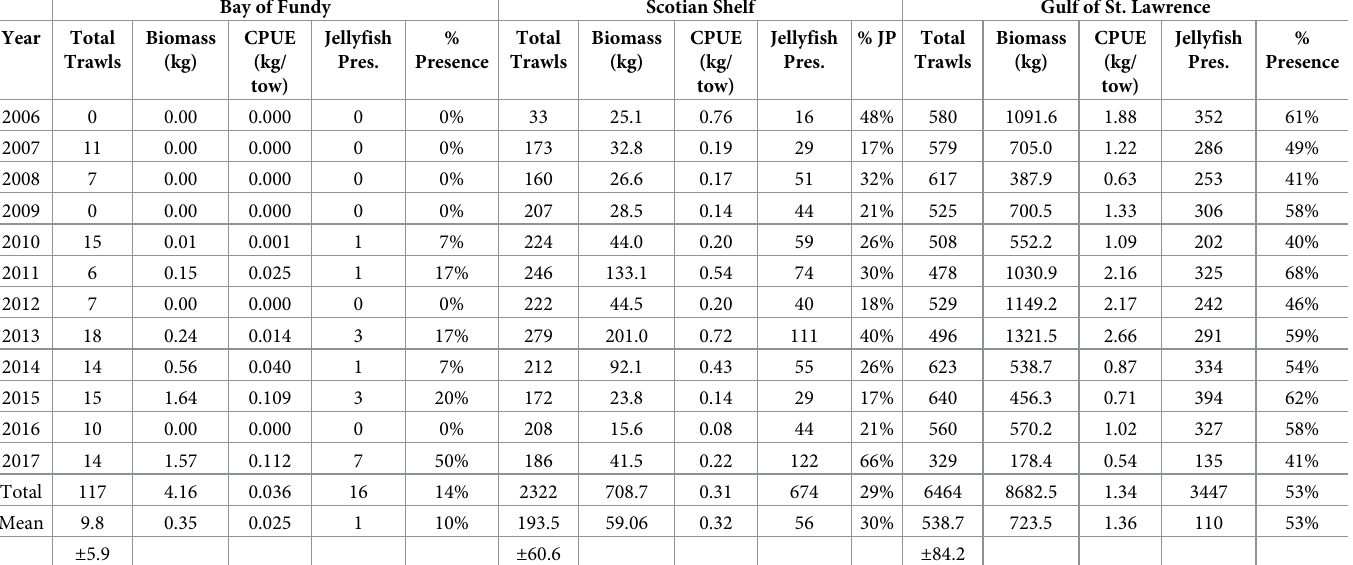
Table 1. DFO groundfish surveys by region and year. ‘Biomass (kg)’ is the wet weight of jellyfish; ‘CPUE’ = catch per unit effort; ‘Jellyfish Pres’ is the number of trawls with jellyfish presence; and ‘% Presence’ is the percent of trawls with jellyfish presence. Bay of Fundy Scotian